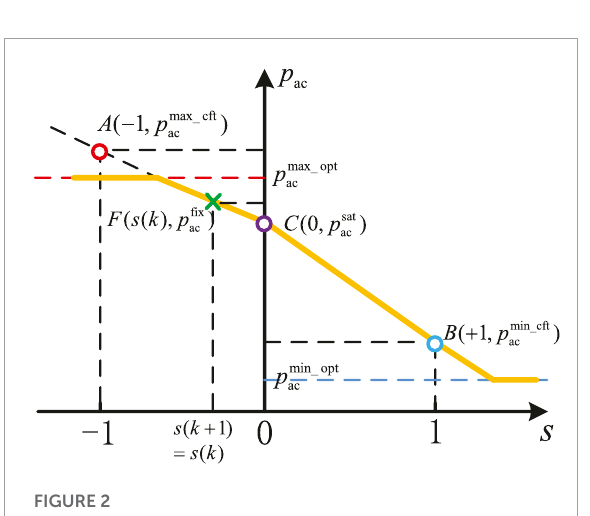
FIGURE 2 Adjustment capability curve (ACC) of one